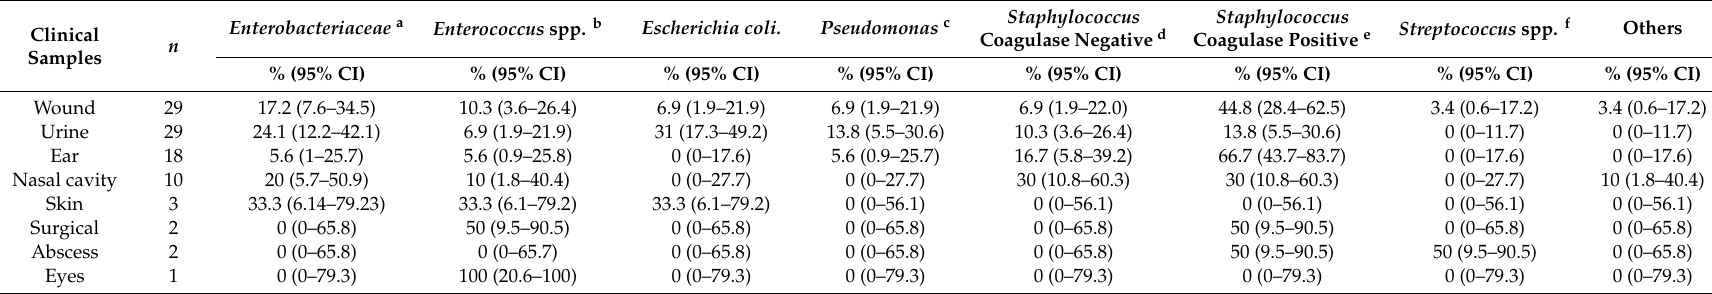
Table 3. Bacterial isolates from clinical samples from cats submitted to the Diagnostic Laboratory of the Faculty of Agrarian Sciences, University of Antioquia